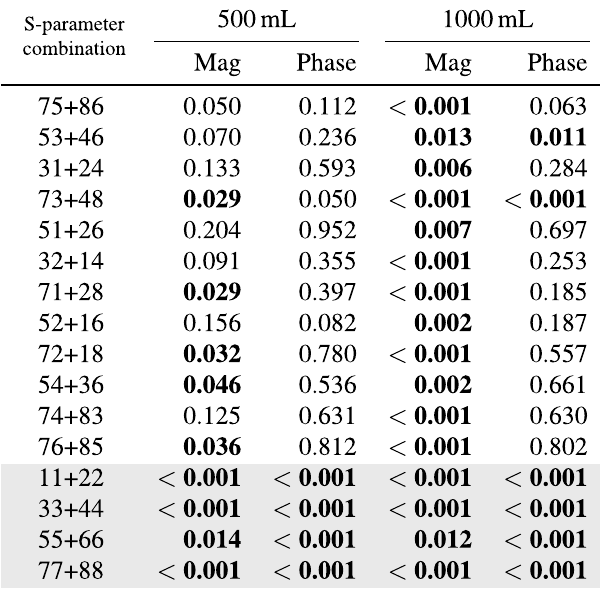
Table 2. The outcomes of the Mann–Whitney U test when comparing baseline to hemoperitoneum for different S-parameter combinations. “Mag” and “Phase” represents the use of coefficient magnitude and phase, respectively. Statistically significant values ( p < 0.05 ) are highlighted in bold text; unshaded rows are transmission coefficients whereas shaded rows are reflection coefficients.